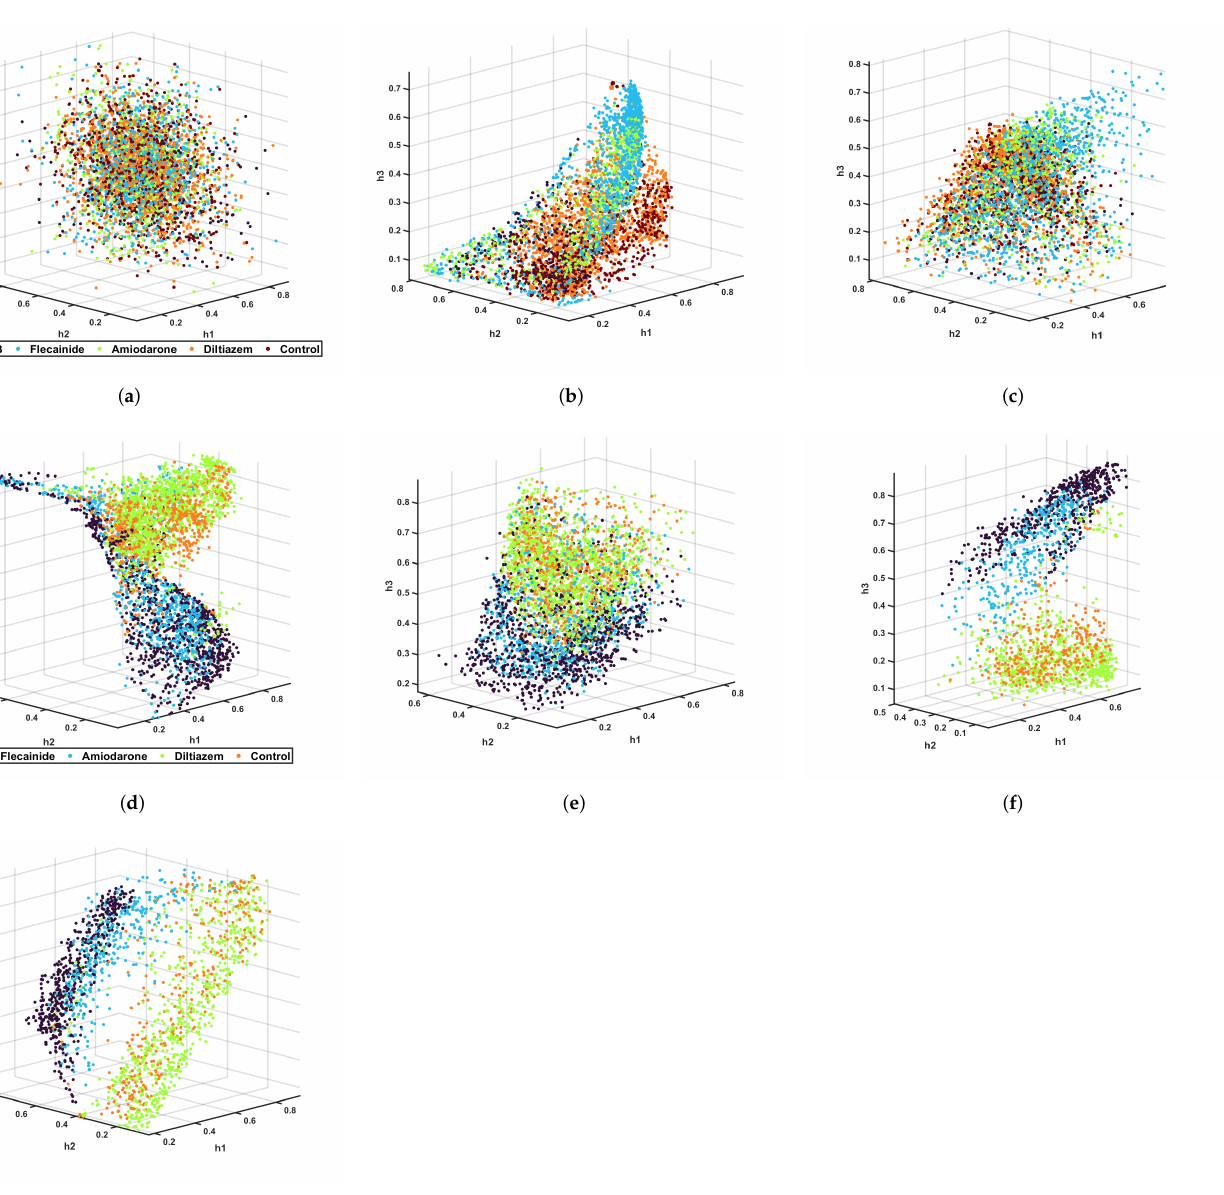
Figure 4. Embedding spaces representing three latent variables for each unsupervised learning scheme. All of the complete (6 min) recordings were used as the windowed-input space in terms of the time ( a ), time-frequency transform ( b ), and audio features ( c ). When the ANSB recordings were not included, this positively affected the structure of the latent variables in the time-frequency transform ( d ) and audio features ( e ). When the ANSB recordings were not included and only the second half of the signals was considered it remained possible to observe different behavior, as seen in time-frequency transform ( f ) and audio-related features ( g